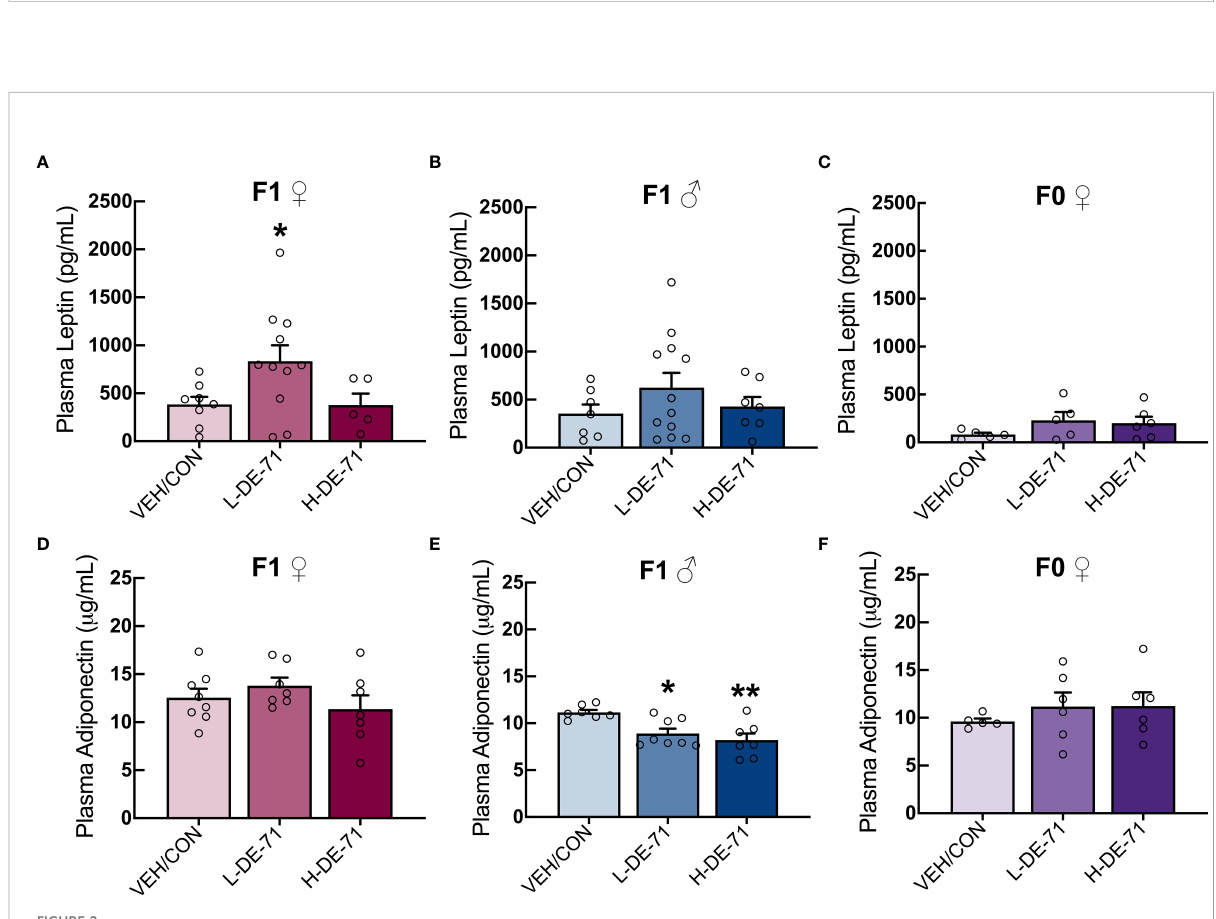
FIGURE 2 Plasma levels of leptin and adiponectin in DE-71-exposed male and female offspring. Female and male offspring were fasted for 12 h and plasma collected and analyzed using commercial ELISA kits. Samples were also processed for dams in ad libitum fed state. (A – C) Mean plasma leptin levels in DE-71-exposed and VEH/CON groups. (D – F) Mean plasma adiponectin levels DE-71-exposed and VEH/CON groups. Asterisk(s) indicate compared to VEH/CON , *p <0.05, **p<0.01. Sample size (n/group): (A) female offspring, 6-11, (B) male offspring, 7-12, (C) dams, 5-6, (D) female offspring, 7-8, (E) male offspring, 7-8, (F) dams, 5-6.